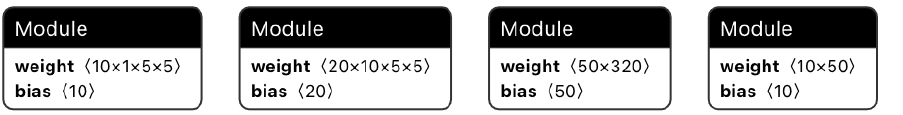
Figure 6. Structure of the network model (left module is the input layer, right module is the output layer, and the other two layers are